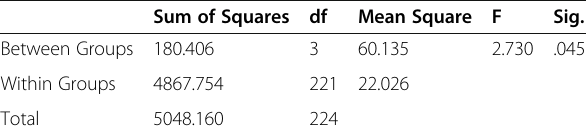
Table 10 One-way ANOVA on Bhutanese Science Teachers ’ Perceptions of the NOS Sum of Squares df Mean Square F Sig. Between Groups